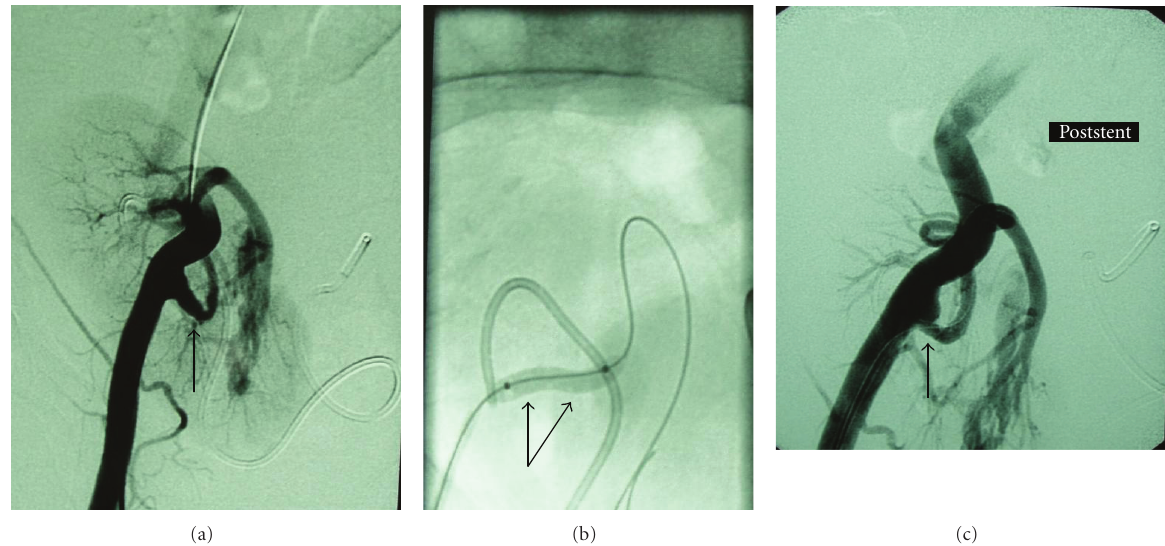
Figure 5: (a) Contralateral angiography revealing kinking with stenosis of the transplant renal artery (arrow). (There is a working tilting of the machine. Note also the ureteral endoprosthesis.) (b) Balloon dilatation of the renal artery stem (arrows) did not succeed to reform the vessel. (c) After stent placement the kinking and stenosis almost disappeared (arrow).